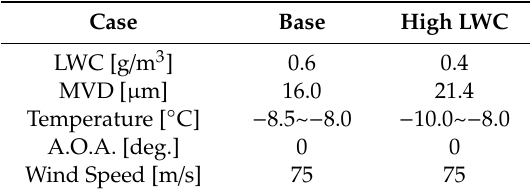
Table 1. Validation Test